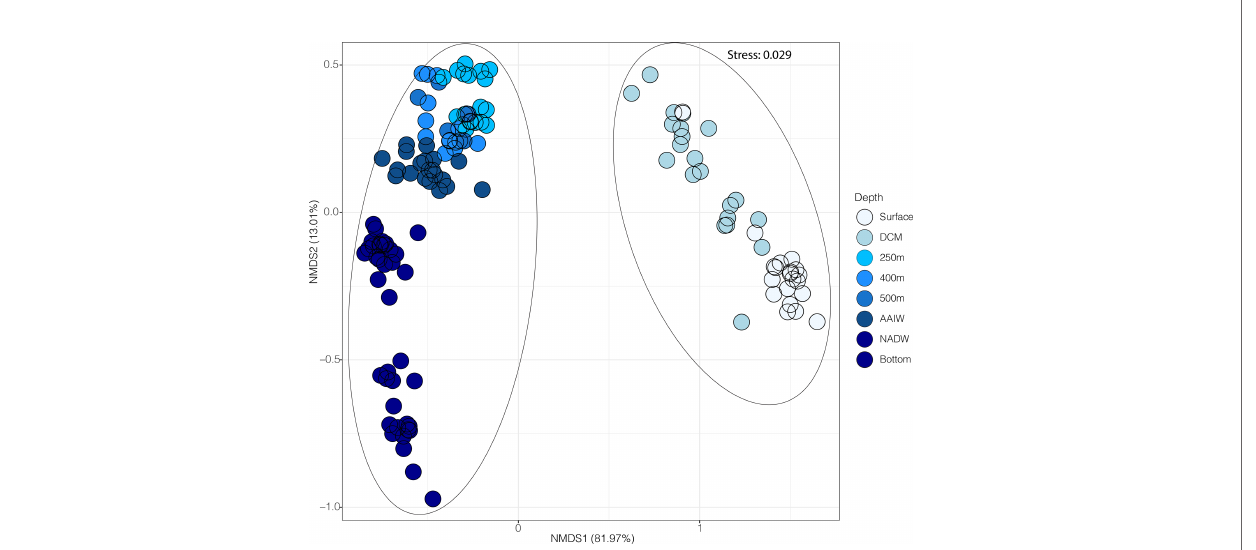
FIGURE 3 | Microbial distribution patterns according to surface (5-150 m) and deep (250-4000 m) across all 23 stations sampled along the full cruise track. NMDS ordinations are based on OTUs resolved from 16S rRNA gene amplicon data, where colour indicates depth sampled, with circled areas re fl ecting signi fi cant ANOSIM results p<0.05, R=0.810, showing distinct microbial communities occurring between two major oceanic depth zones: surface (0-150 m) and deep (250 - 4000 m) waters. The amount of variation explained by each of the NMDS axes are shown in parentheses.